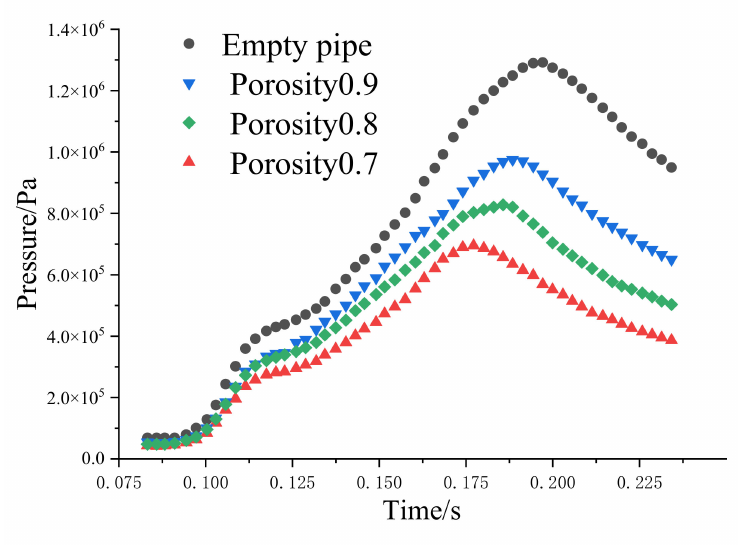
Figure 24. The curves of pressure versus time for empty pipe and the pipe with 80 cm copper foam for different porosities